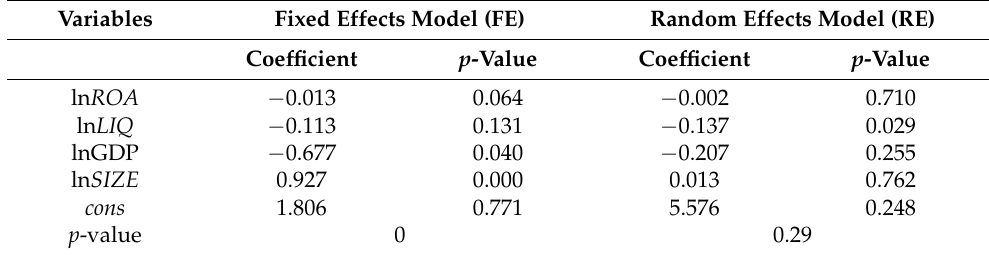
Table 4. Results for FE and RE using α = 0.05 with